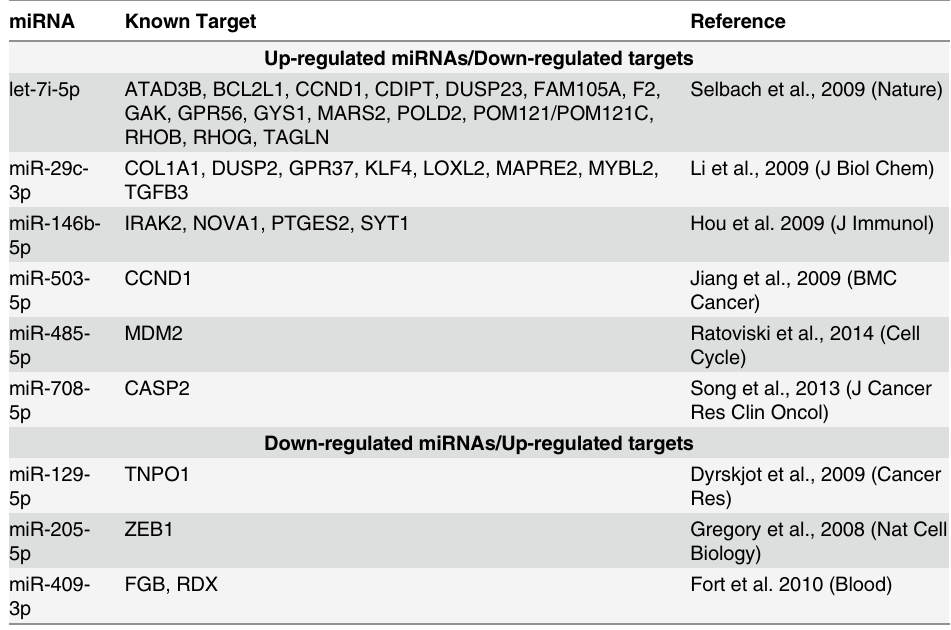
Table 3. miRNA-mRNA pairs found inversely correlated and validated in the literature. miRNA Known Target